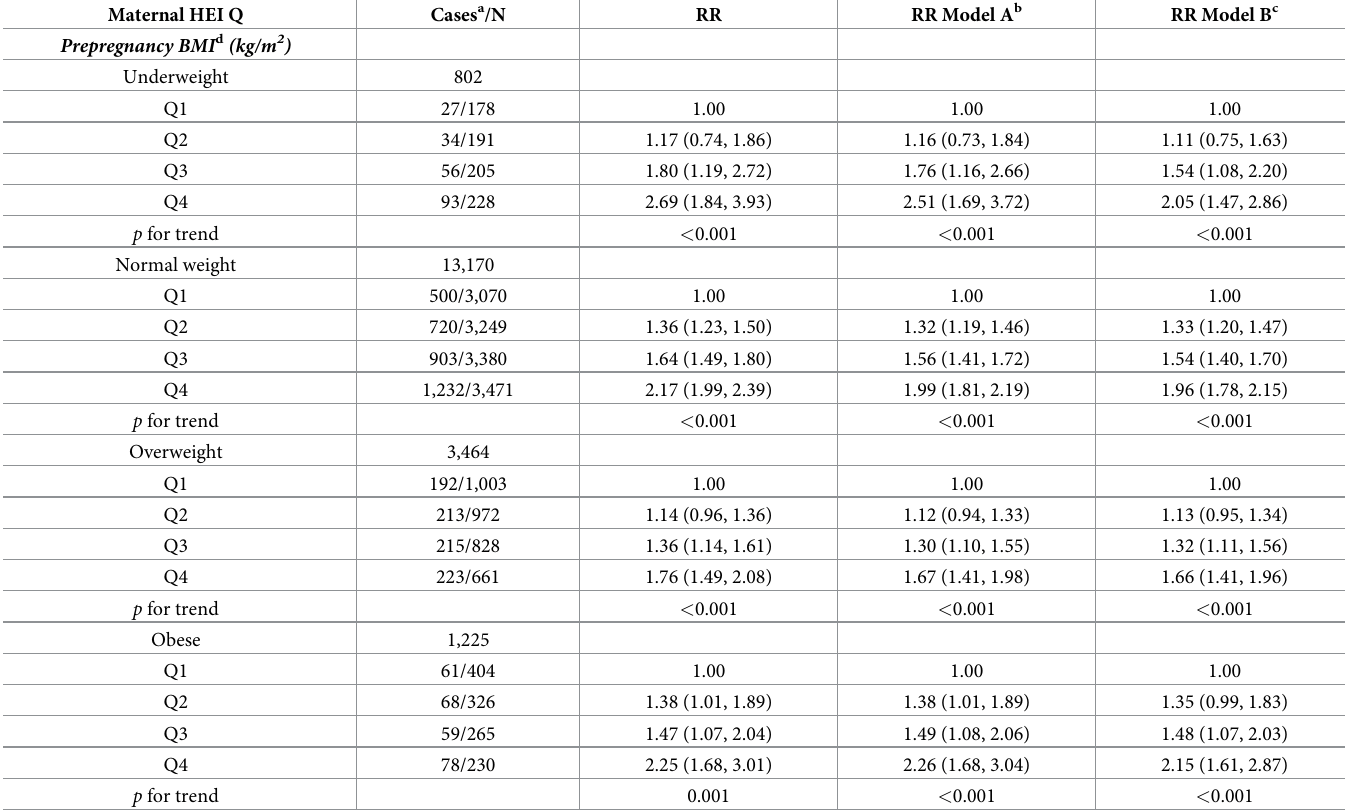
a Cases = the number of offspring in Q4 according to ranking of the mother. b Adjusted for maternal age, parity, education, physical activity, smoking and alcohol intake during pregnancy, and lactation. c Additionally adjusted for offspring energy intake and sex.